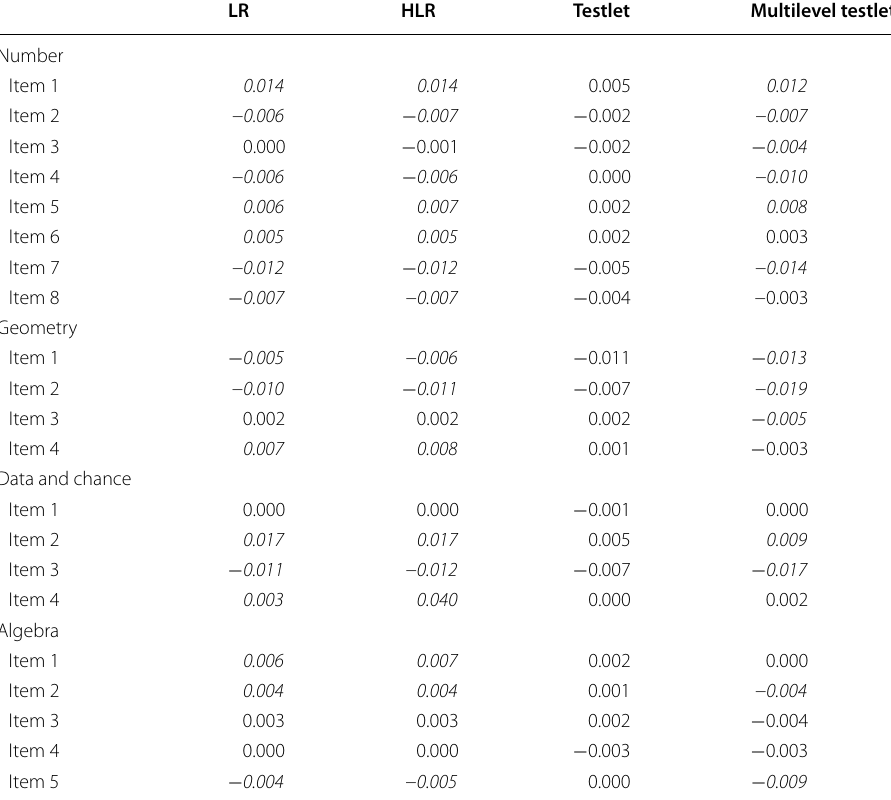
Italised DIF parameter estimates are significant at 5